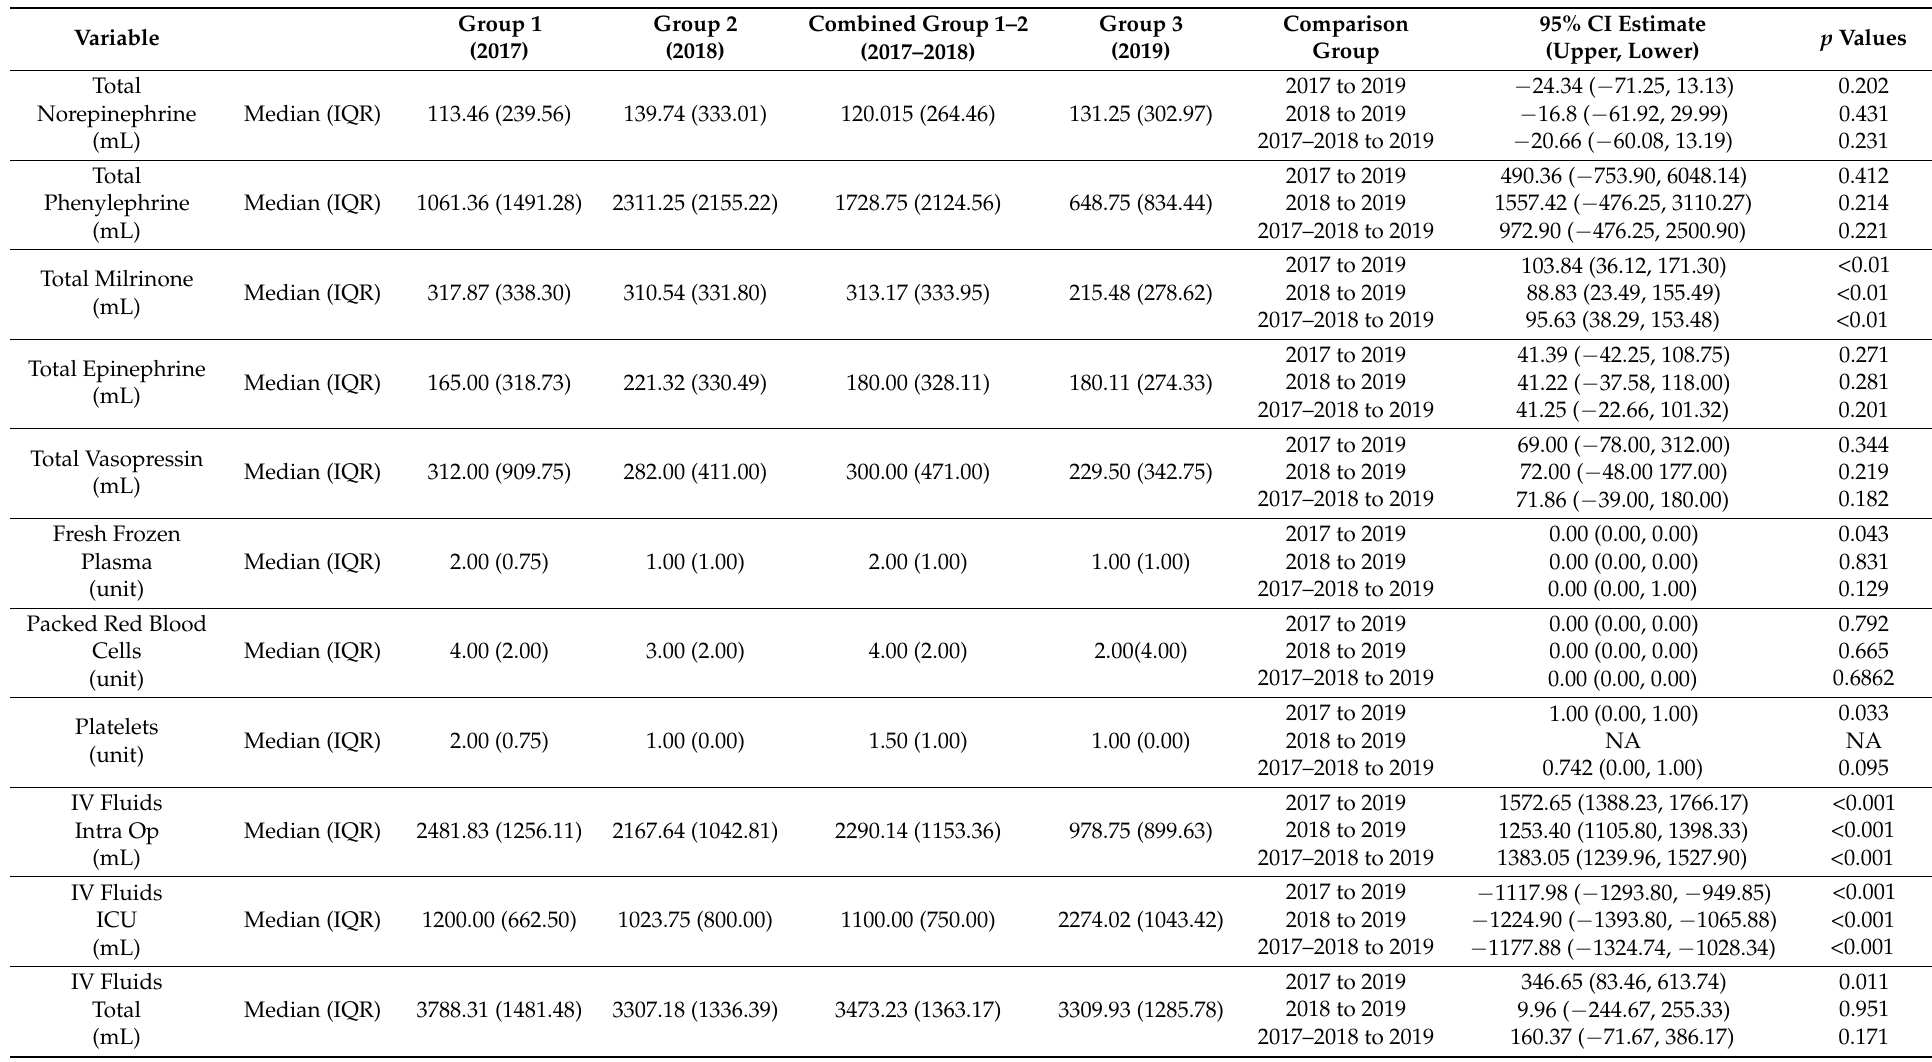
Table 3. Amount of vasopressor, blood products and IV fluid